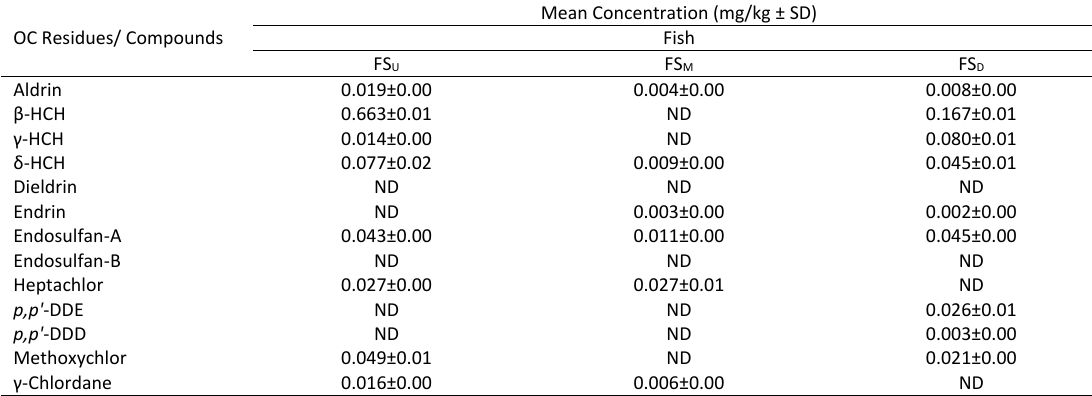
Table 1: Mean concentrations of OC residues in fish across sampling zones OC Residues/ Compounds